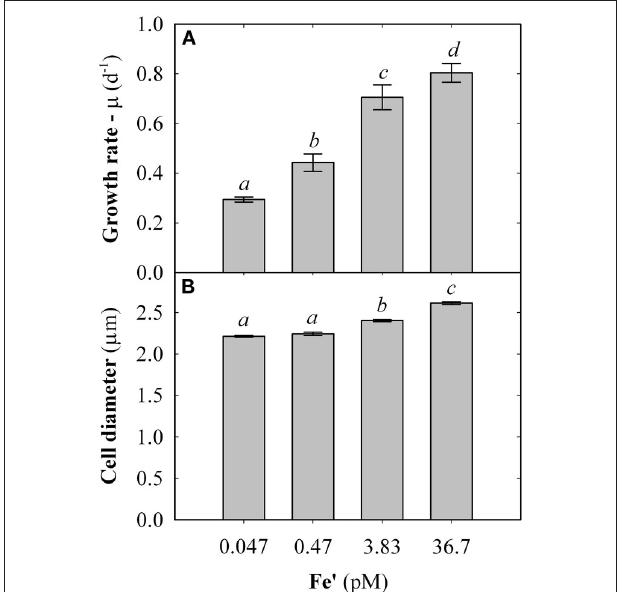
FIGURE 1 | Physiological changes in response to bioavailable iron (Fe) in the culture medium. (A) Growth rate. (B) Cell diameter. Error bars represent standard deviation. Letters indicate no statistical significant difference amongst treatments ( P > 0.05). Holm-Sidak method used for pairwise multiple